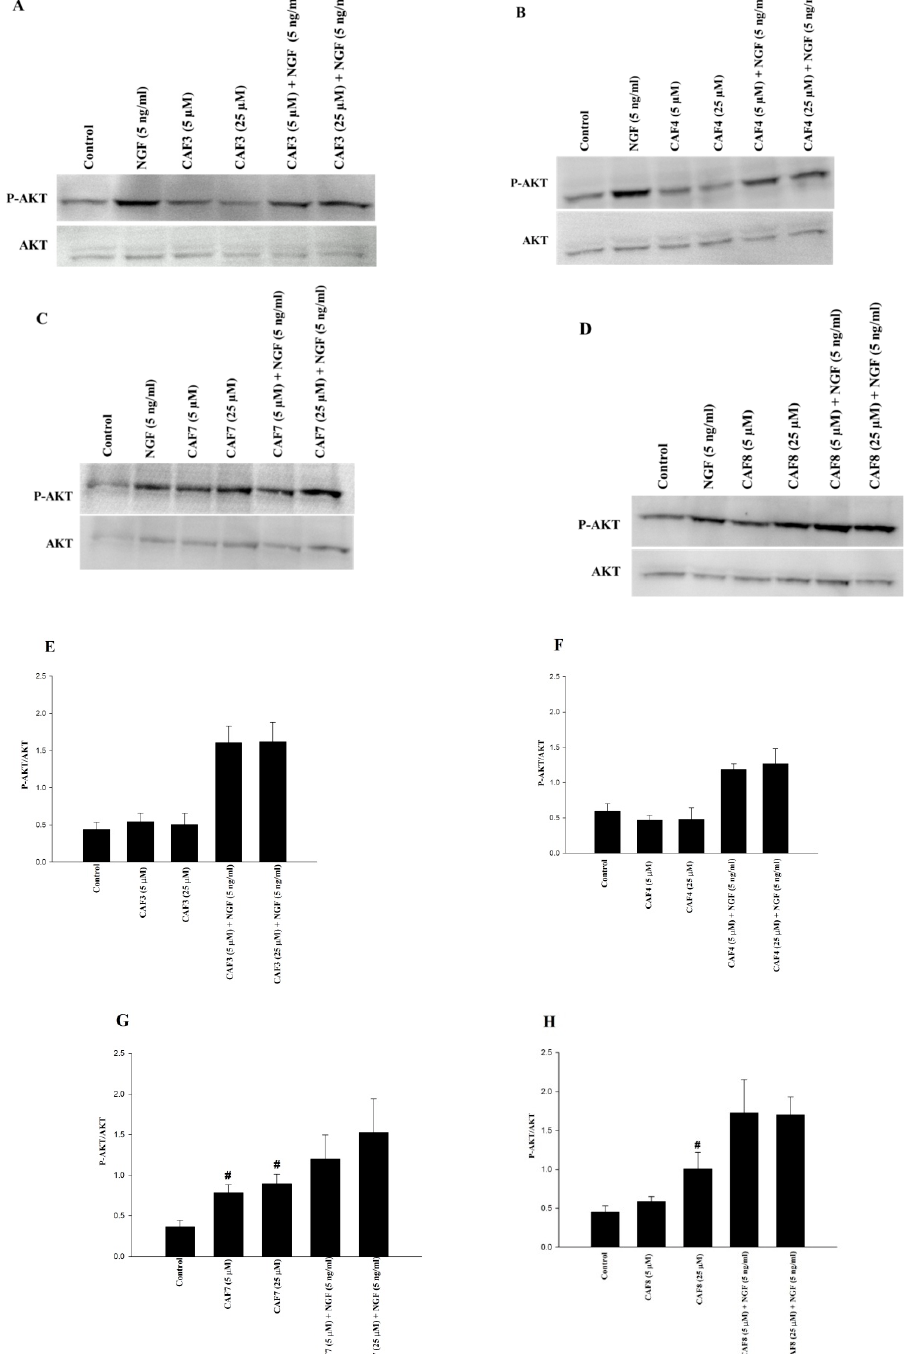
Figure 6. Assessment of AKT phosphorylation in PC12 cells treated with synthesized caffeate esters. PC12 cells were seeded in collagen-coated petri dishes and exposed to caffeate esters and/or NGF (5 ng/mL). After 120 min, the total cell protein was harvested, separated by 7.5% SDS − PAGE, transferred onto a PVDF membrane and probed with specific antibodies ( A – D ). The band intensities of p-AKT and AKT were quantified. The intensity of each p-AKT band was first divided by the band intensity of the respective AKT. The p-AKT/AKT ratio in drug-treated cells was then normalized to this ratio in NGF-treated cells ( E – H ). The figures show the mean of four experiments ± SEM. # Significantly different from untreated control cells ( p <